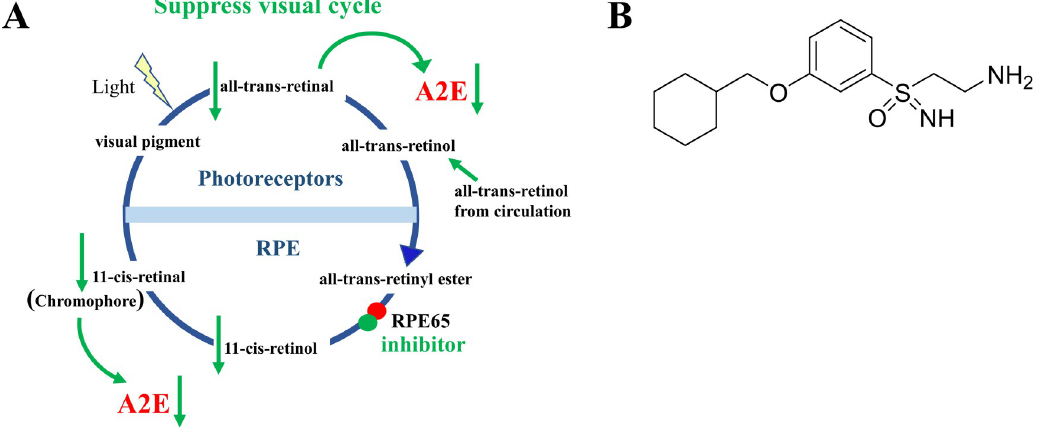
Fig 1. Scheme of visual cycle and structure of inhibitor ( ± )-RPE65-61. (A) Schematic representation of the visual cycle and the target of ( ± )- RPE65-61 . The visual cycle includes a series of biochemical reactions, one of the key steps is the conversion of all- trans -retinyl ester to 11- cis -retinol by RPE65 isomerase. All- trans -retinol converted through a cascade of enzymatic reactions in the retinal pigmented epithelium (RPE), producing a light sensitive chromophore 11- cis -retinal, which binds with opsin and allows photon capture in photoreceptor outer segment. All- trans -retinal and 11- cis -retinal, when accumulated in excessive amounts, can lead to production of A2E which causes oxidative stress and ocular diseases. RPE65-61 selectively inhibits isomerase activity of RPE65 and prevents the retinal damage by slowing down the accumulation of all- trans -retinal in light-induced retinal damage animal model. (B) ( ± )- RPE65-61 chemical structure.